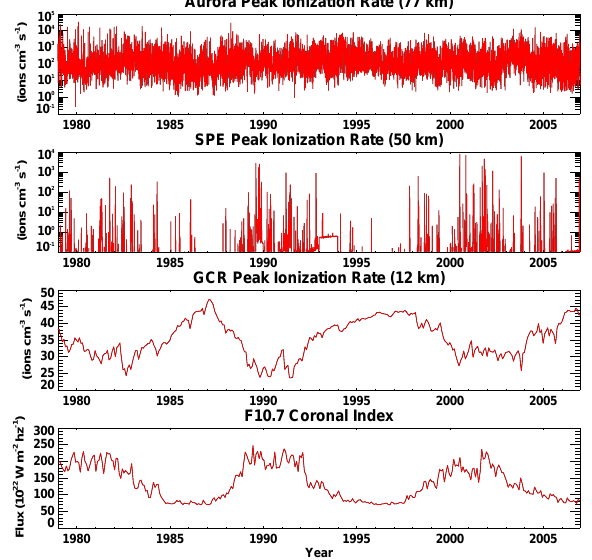
Fig. 2. Timeseries of peak ion pair production for aurora (top panel), SPEs (second panel) and GCR (third panel). Auroral zone electrons and SPEs data is daily but GCR data is monthly. The F10.7 index variation is shown in the bottom panel.